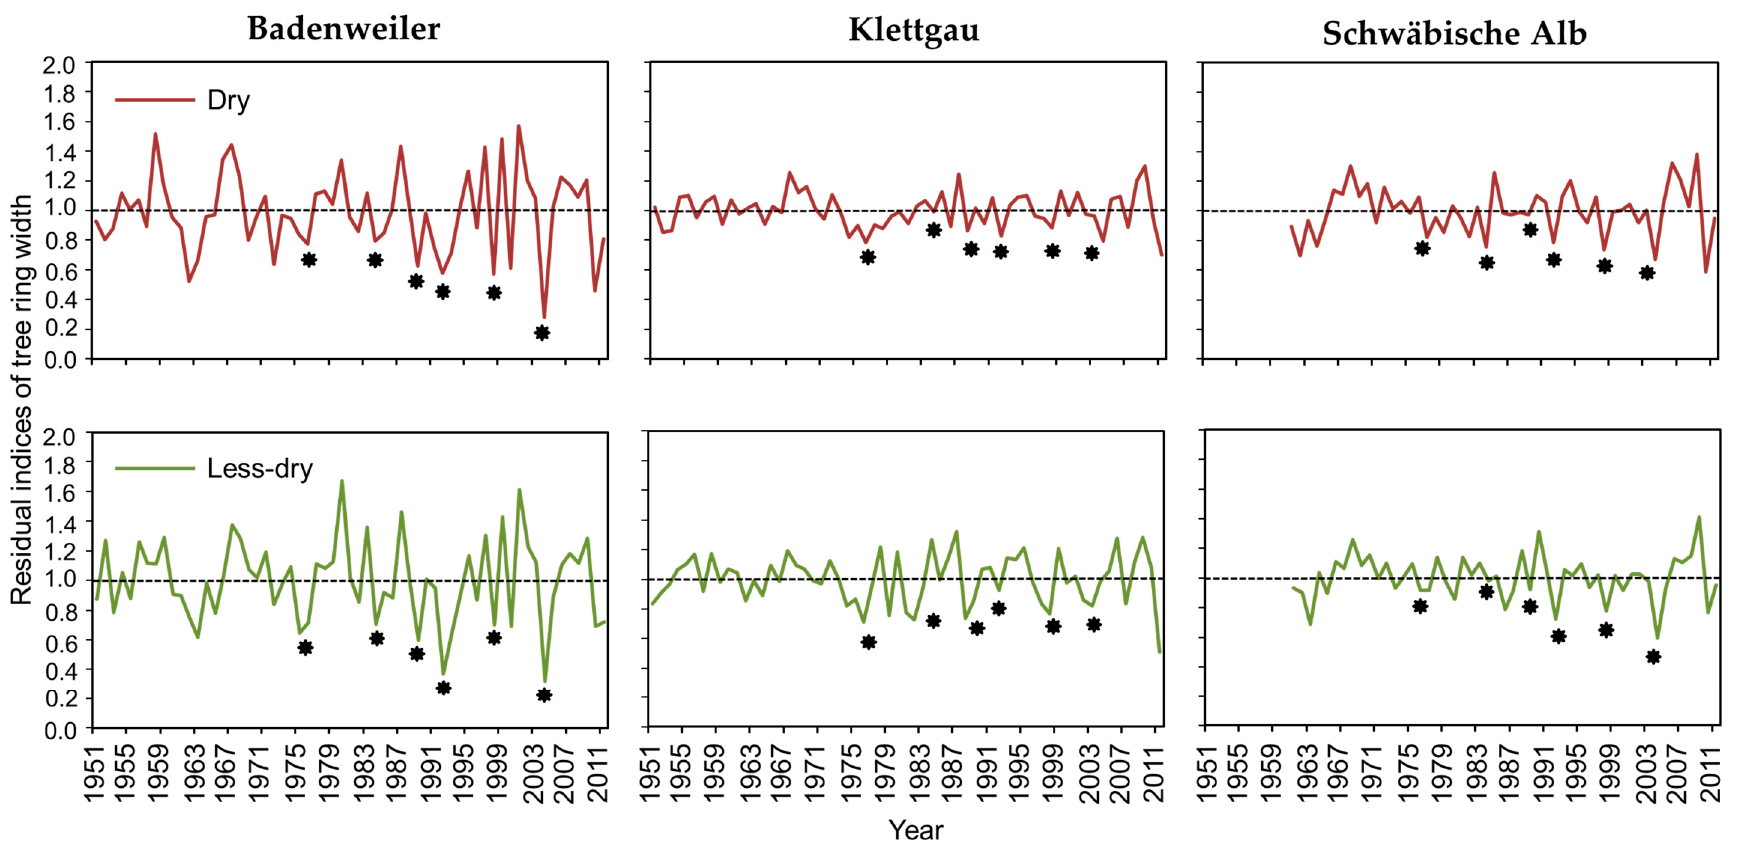
Figure 3. Chronology series of residual indices for the tree ring width of dry and less-dry plots for Badenweiler, Klettgau, and Schwäbische Alb. Chronology series are shown from 1951 to 2011 for Badenweiler and Klettgau, and from 1961 to 2011 for the Schwäbische Alb. The black dashed line through the value 1.0 indicates the control over the growth; values above the line mean higher growth, where below the line means depression. Black stars indicate six drought years (1976, 1984, 1989, 1992, 1998, and 2003) that were used for the resistance, recovery, and resilience analysis of the trees. Graphs in columns indicate data for Badenweiler, Klettgau, and Schwäbische Alb from left to right, respectively.